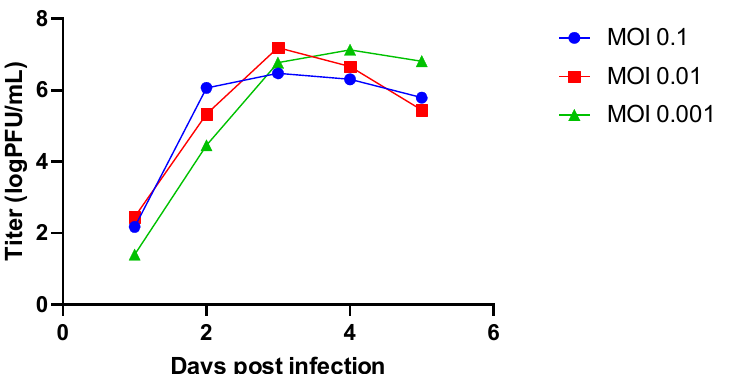
Figure 1. Mumps virus (MuV) replication in Vero cells. Vero cells in layers were infected with MuVi- C at different multiplicities of infection (MOIs). Supernatants were collected from day 1 to day 5 post infection. Titres in the supernatants were determined using a plaque assay.